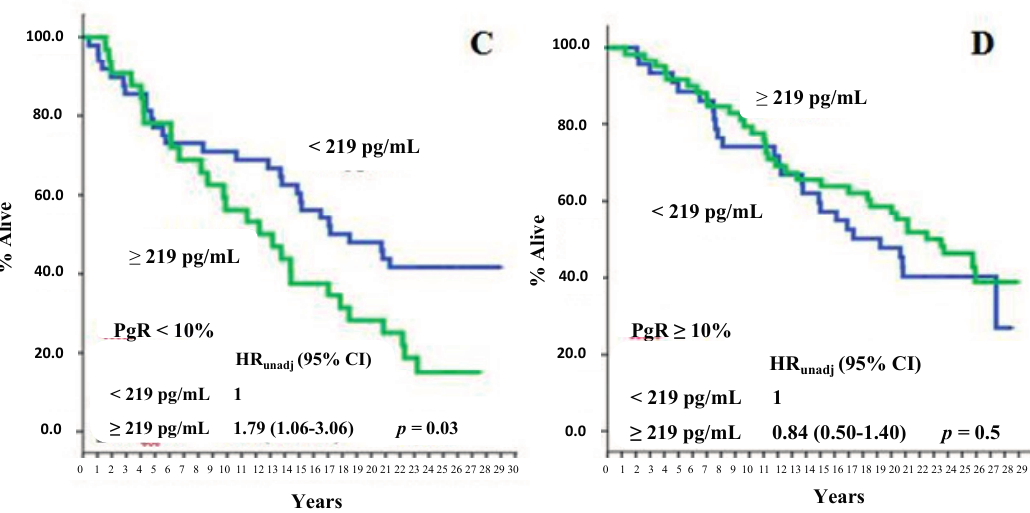
Figure 2. All-cause mortality of study patients as a function of serum PN values, according to nodal status ( A , B ) and PgR status ( C , D ). The median PN value, corresponding to 219 pg/mL, was used as an arbitrary cutoff. HR : hazard ratio; 95% CI : 95% confidence interval.